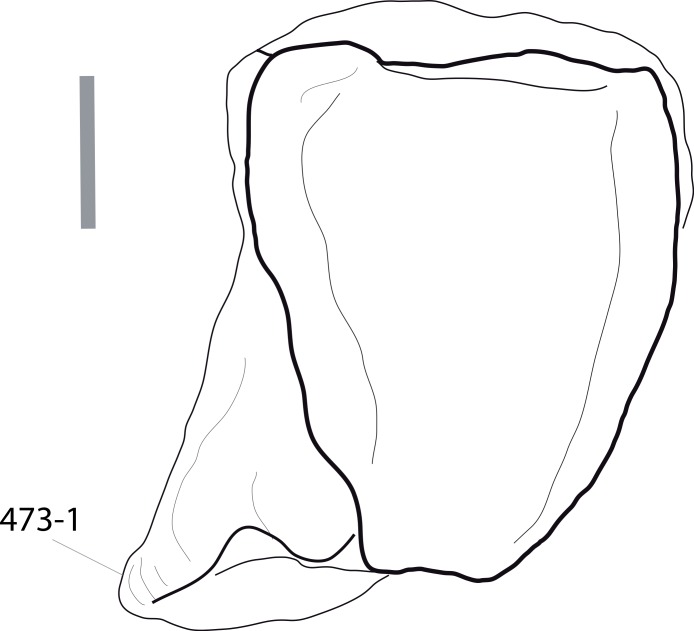
Pedal phalanx I-1 of the indeterminate apatosaurine NHMUK R3215 in medial view.Note the ventral shelf (C473-1). Scale bar = 2 cm.